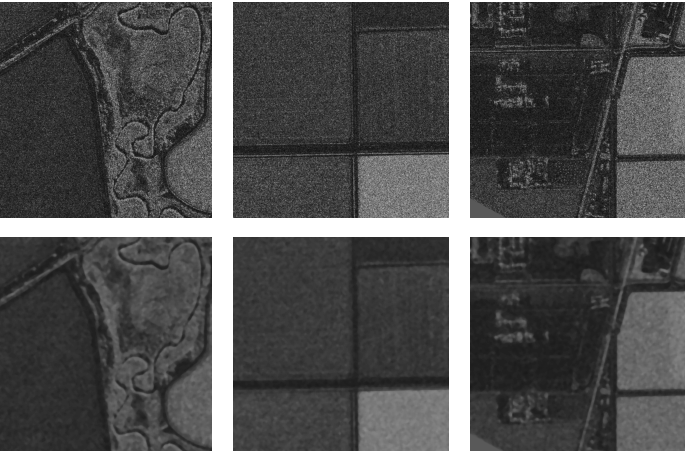
Figure 5. Two pairs of the images before (X—input) and after filtering